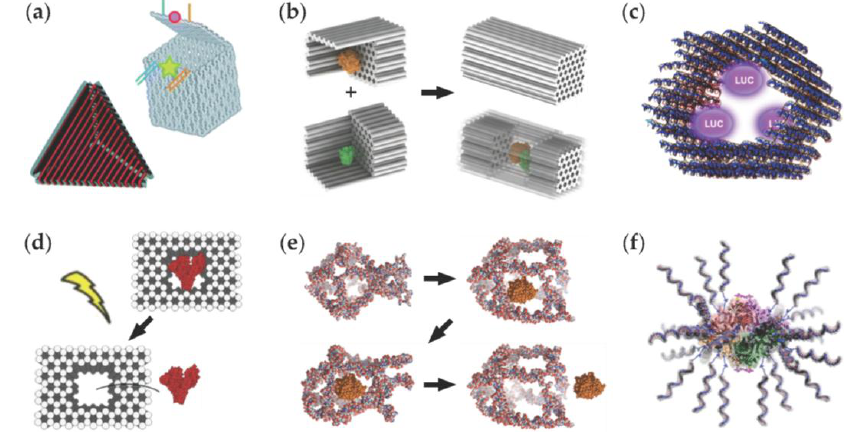
Figure 5. ( a ) Hollow DNA origami containers: a box with a switchable lid [56] and a tetrahedron [57]; ( b ) Two half-cages equipped with glucose oxidase (GOx, orange) and horseradish peroxidase (HRP, green) can form a closed box and encapsulate the enzymes. The closed box efficiently protects the